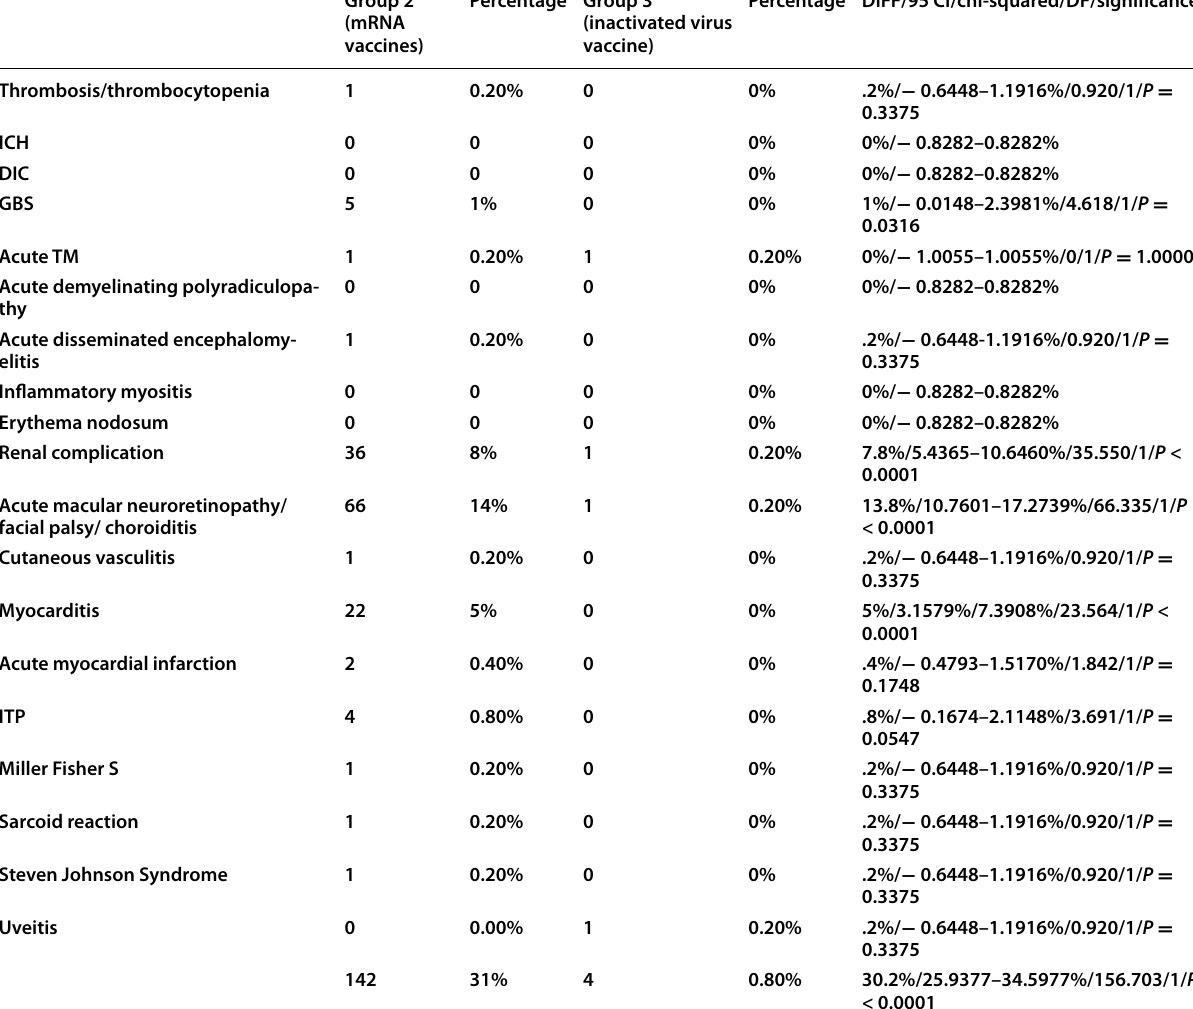
Table 3 Comparison between group 2 (pts received mRNA-based vaccines with adverse events) vs group 3 (pts received inactivated virus-based vaccines with adverse